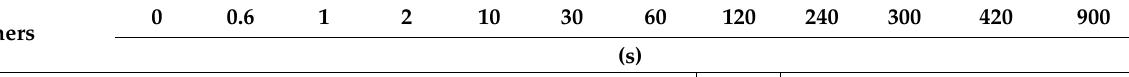
Table 6. Pressing time levels for the production of